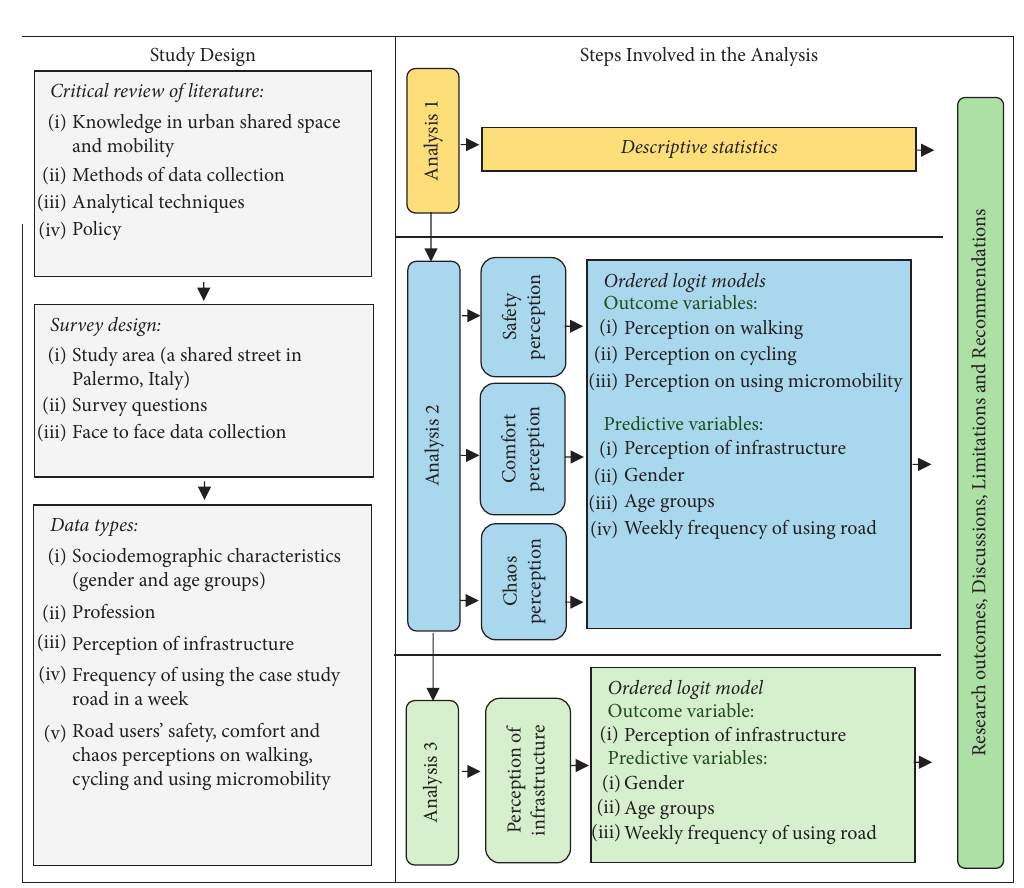
Figure 2: Methodological